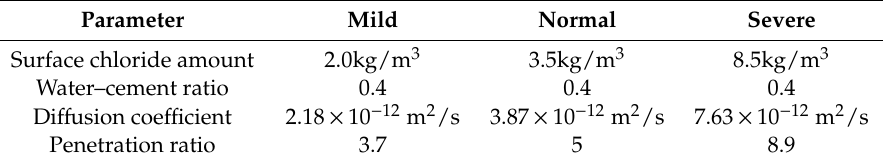
Table 2. Description of corrosive parameters for various corrosive environments.